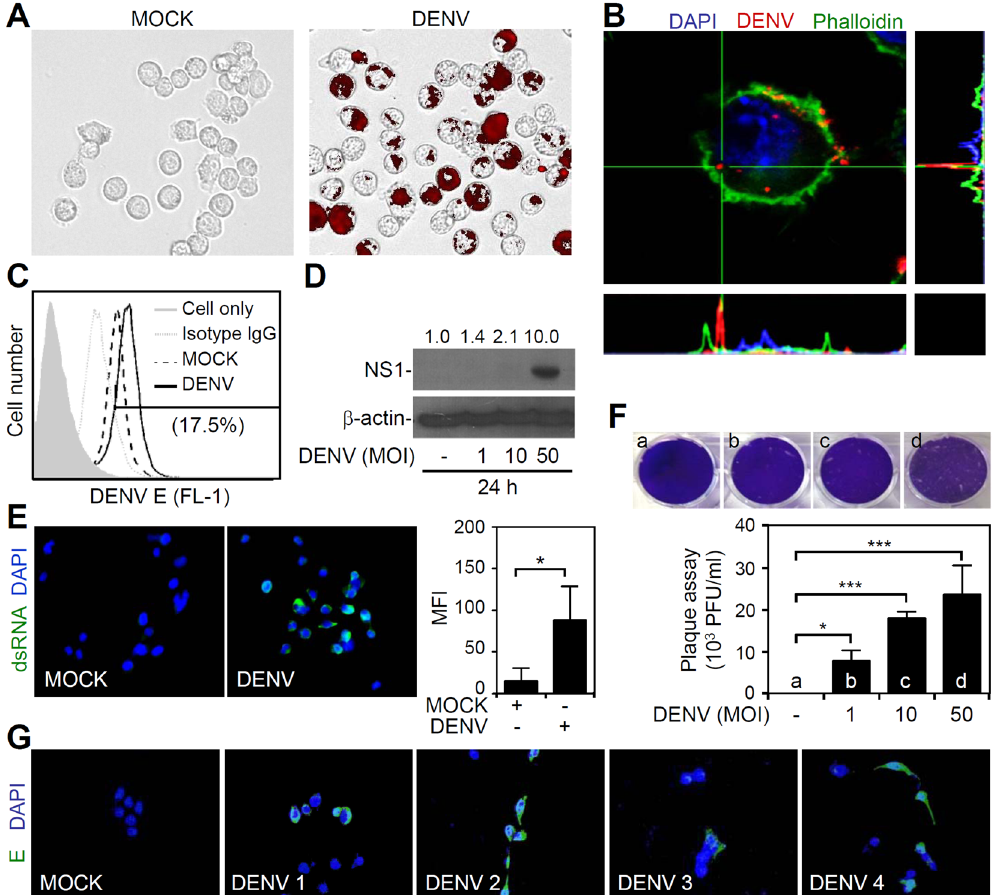
Figure 1. DENV causes infection, including entry, viral protein expression, and replication, in the microglial cell line BV2. Microglial BV2 cells were inoculated with Alexa-594 labeled ( red ) DENV serotype2 PL046 (MOI = 50) for 2 h. ( A ) Fluorescent image analysis showed microglial cells carrying fluorescent DENV 2. ( B ) Three-dimensional confocal images confirmed viral entry. Phalloidin ( green ) staining indicated actin. ( C ) Flow cytometry analysis demonstrated viral envelope ( E ) protein expression 24 h post-infection. ( D ) Western blotting analysis showed viral nonstructural protein1 ( NS1 ) expression in DENV-infected cells. The relative ratio to β -actin is shown. ( E ) Immunocytochemistry and its relative mean fluorescence intensity ( MFI ) of viral dsRNA 24 h post-infection. ( F ) Plaque assays showed the level of viral replication. ( G ) Immunocytochemistry showed viral E protein expression ( green ) in cells infected with the four DENV serotypes. For all images and blots, representative data were selectively obtained from three individual experiments. DAPI staining indicated the nuclei ( blue ). For the flow cytometry analysis, the percentage of positive cells is shown. All quantitative data are shown as the means ± SD from three independent experiments. * p < 0.05, ** p < 0.01, and *** p <